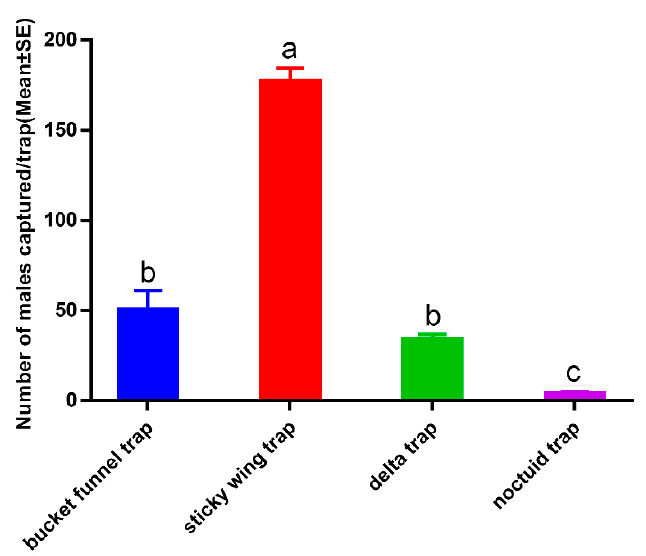
Figure 7. Effect of trap design on catch of Ectropis grisescens male moths. Bars mean standard error. Different letters indicate significant difference (Tukey’s HSD test, p < 0.05).